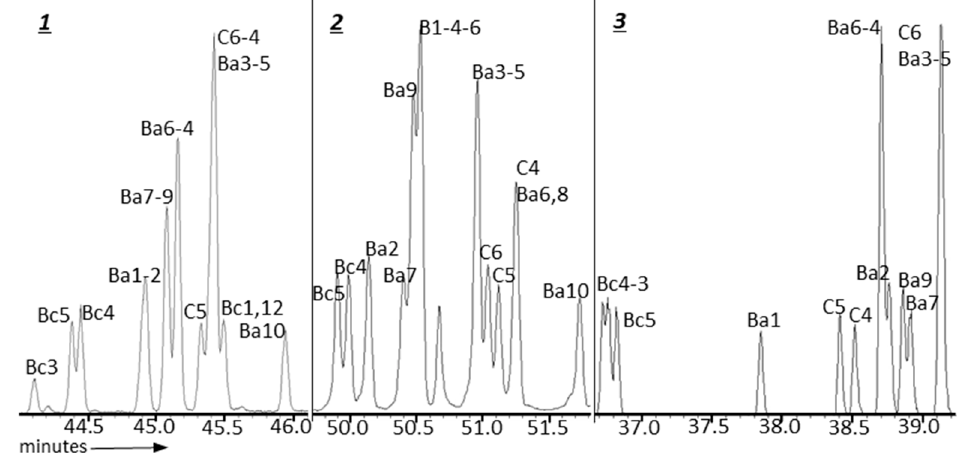
Figure 3. Elution order of methyl-benz( a )anthracenes, chrysenes and benzo( c )phenanthrenes and dimethylbenzo( c )phenanthrenes on phenyl arylene ( 1 ), 50% phenyl-polysiloxane ( 2 ) and SLB-ILPAH dimethylbenzo( c )phenanthrenes on phenyl arylene (1), 50% phenyl-polysiloxane (2) and SLB-ILPAH ( 3 ) stationary phases. For abbreviations see Table (3) stationary phases. For abbreviations see Table 2.